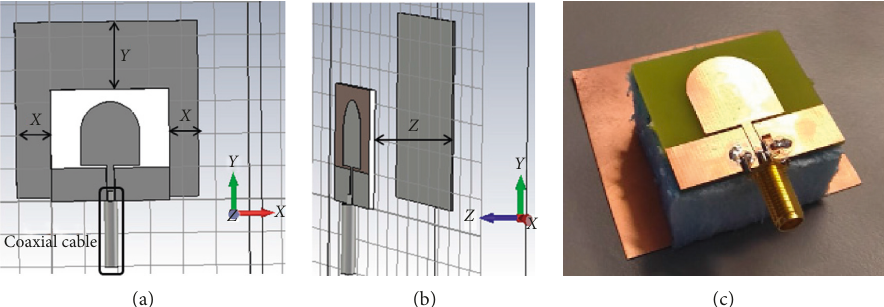
Figure 10: Simulated reflector-backed antenna model. (a) Front and (b) side. (c) Prototyped reflector-backed structure.